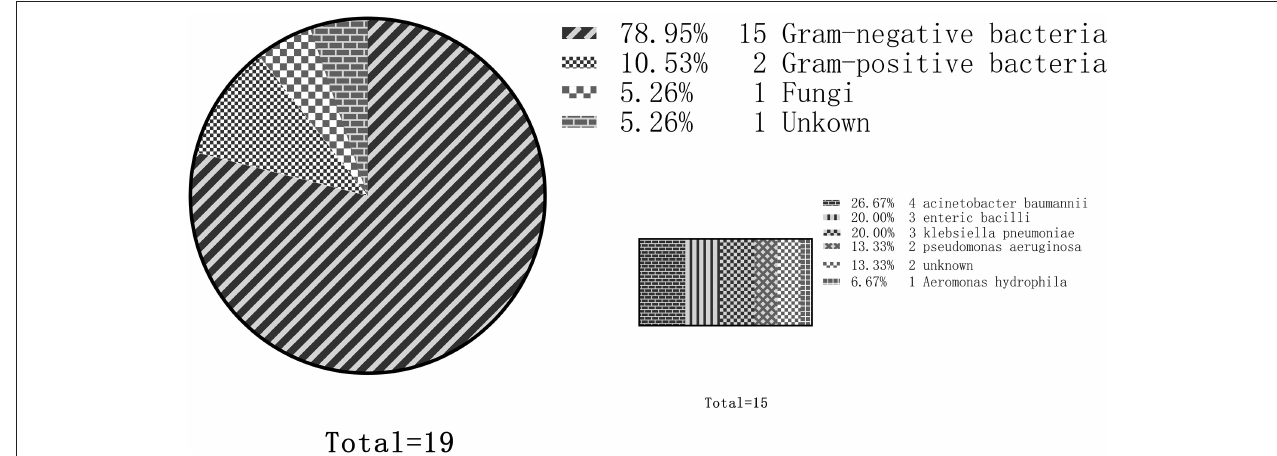
FIGURE 2 | Distribution of nosocomial infection etiology in adult patients treated by extracorporeal membrane oxygenation (ECMO). Out of the 19 total studies, 15 studies reported that gram-negative bacteria were the predominant pathogens. Among them, the most common were Acinetobacter baumannii (four